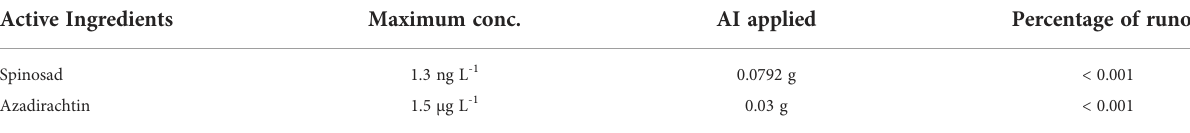
TABLE 5 The calculated percentage runoffs of the insecticides generated from the detected maximum concentrations of the insecticides in the nutrient solution and the concentrations of the applied active ingredients (AI) per treatment. Active Ingredients Maximum